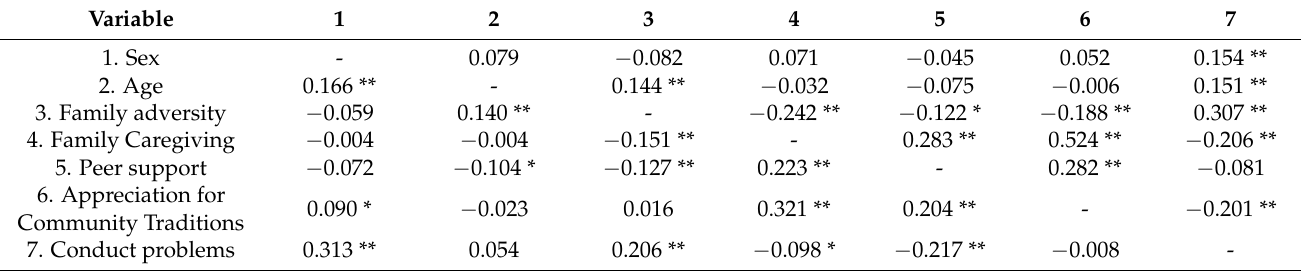
Table 1. Intercorrelations among study variables disaggregated by country.